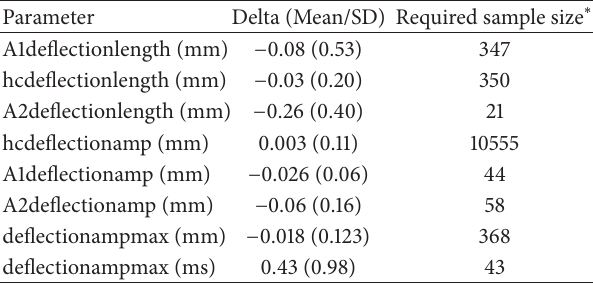
Table4:Samplesizecalculationforthedeflection-basedparameters calculated using the new CST research